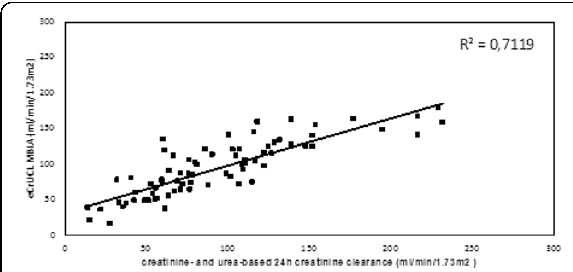
Fig. 1 (abstract 0417). correlation observed vs MBIA-predicted 24h CrUCL (ml/min/1.73